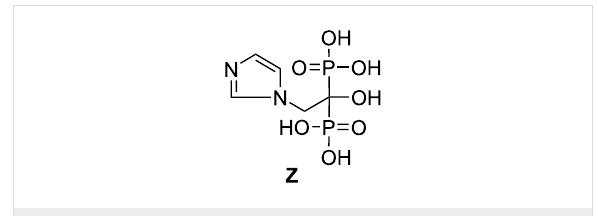
Figure 1: Structure of zoledronic acid.